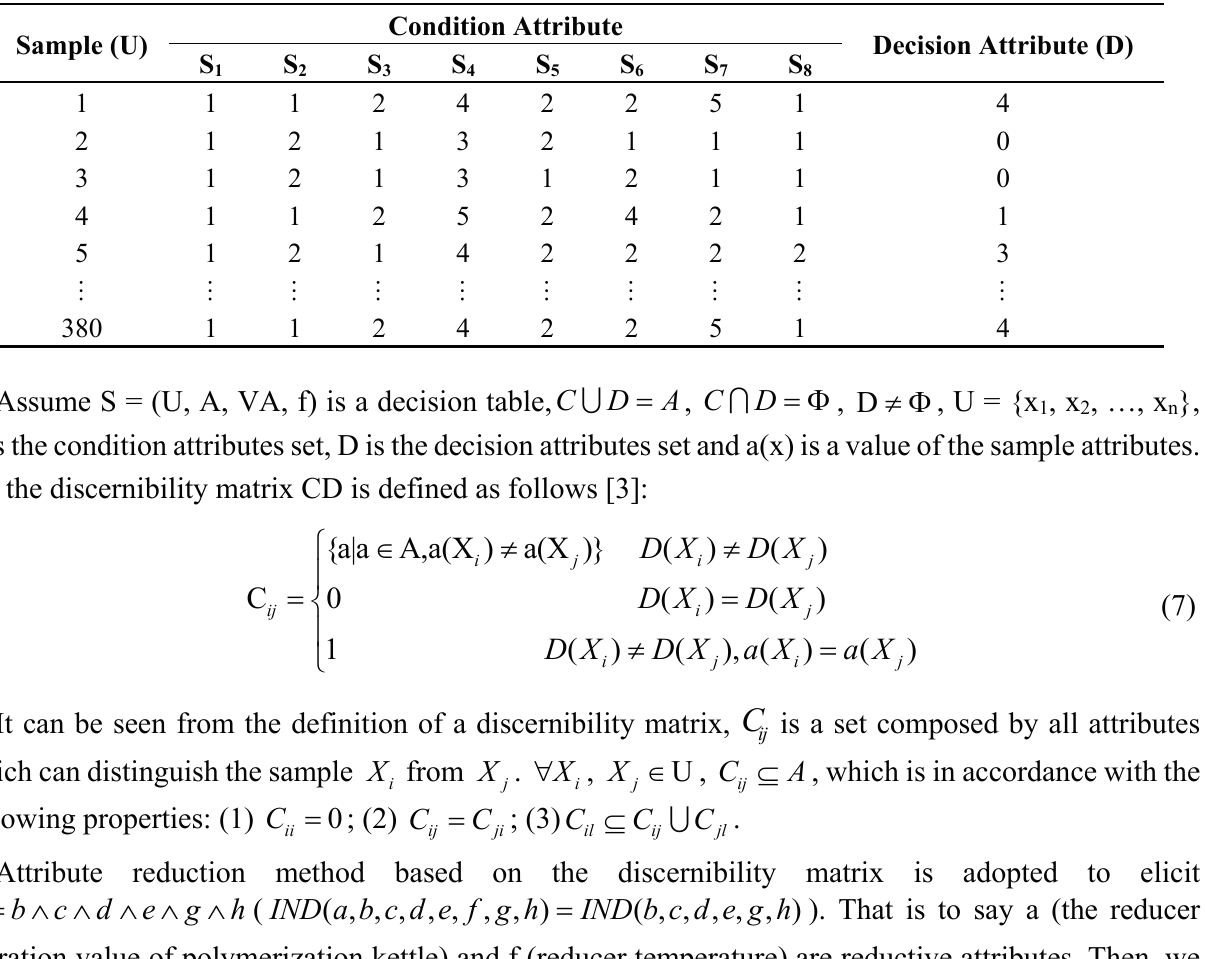
Table 2. Fault diagnosis decision table of